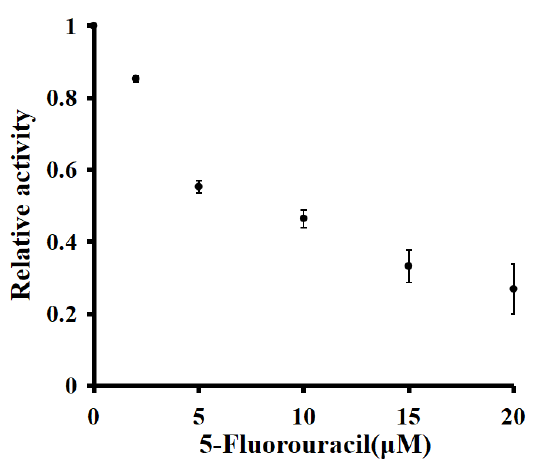
Figure 5. Effect of 5-fluorouracil on MTase activity. Error bars were estimated from three replicate measurements.